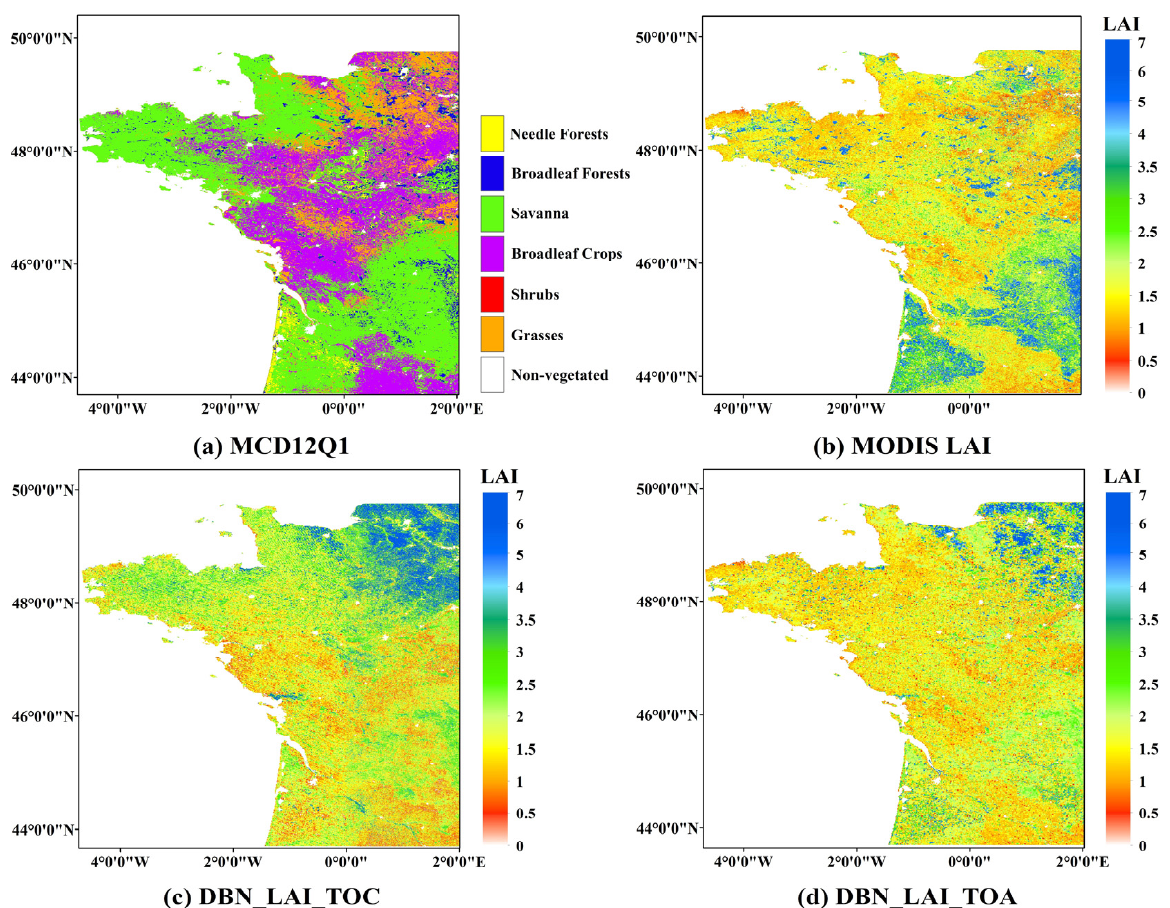
Figure 4. LAI inversion results. The four maps in each figure cover the same area. From ( a ) to ( d ), they represent the land cover type (MCD12Q1), the MODIS LAI (MOD15A2H), the DBN_LAI_TOC (LAI retrieval from the TOC reflectance using the DBN algorithm), and the DBN_LAI_TOA (LAI retrieval from the TOA reflectance using the DBN algorithm), respectively. The land cover type map only shows the vegetation coverage area, and the non-vegetation area is shown in white in panel ( a ). For the selected region in 2014, there was no obvious difference between DBN LAI and MODIS LAI for each year and for each of the six biomes. However, the slight difference can be seen in the calculated mean average difference (MAD) of LAI. On the land cover of needle forests, broadleaf forests, and savanna, the MAD of DBN_LAI_TOA was larger than that of DBN_LAI_TOC; on broadleaf crops, shrubs, and grasses, the MAD of DBN_LAI_TOA was smaller than that of DBN_LAI_TOC. On the land cover of needle forests, broadleaf forests, savanna, and grasses, the MAD of DBN_LAI_TOC and DBN_LAI_TOA were both less than zero, which means that, taking MODIS LAI as a reference, the frequency of underestimating LAI is higher. For broadleaf crops and shrubs, the MAD of both DBN LAI is greater than zero, which meant that the frequency of overestimating LAI is higher. From Figure 5g, we can see that, for all the biomes, DBN_LAI_TOC and DBN_LAI_TOA both underestimated LAI compared with MODIS LAI, and the underestimation frequency of DBN_LAI_TOA was higher than that of DBN_LAI_TOC. For the region in 2015, no matter for each biome or all the biomes, DBN_LAI_TOA had a higher frequency of underestimating LAI, while DBN_LAI_TOC had a higher frequency of underestimating LAI in needle forests, broadleaf forests, and savanna, but the frequency of LAI overestimation was high on broadleaf crops, grasses, and all the biomes. Furthermore, the MAD of DBN_LAI_TOA was smaller